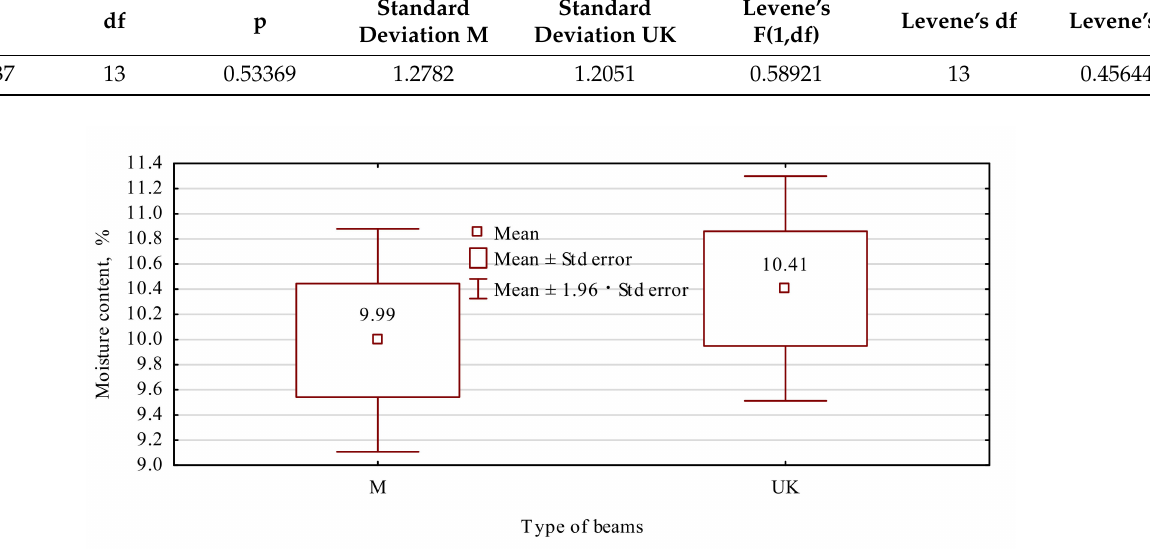
Figure 6. Moisture content of manufactured beam